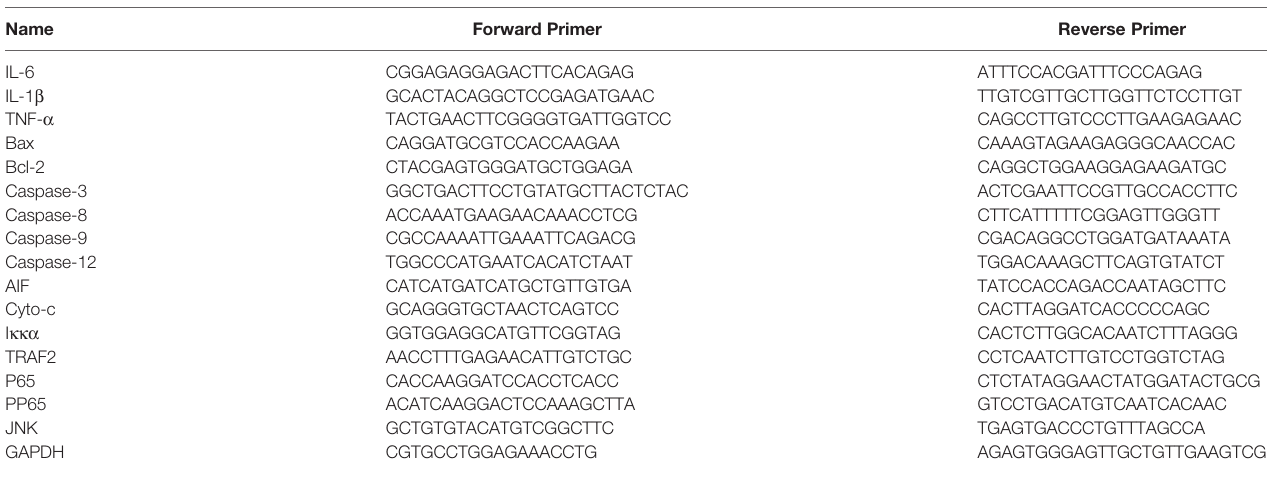
TABLE 2 | Macrophage primer